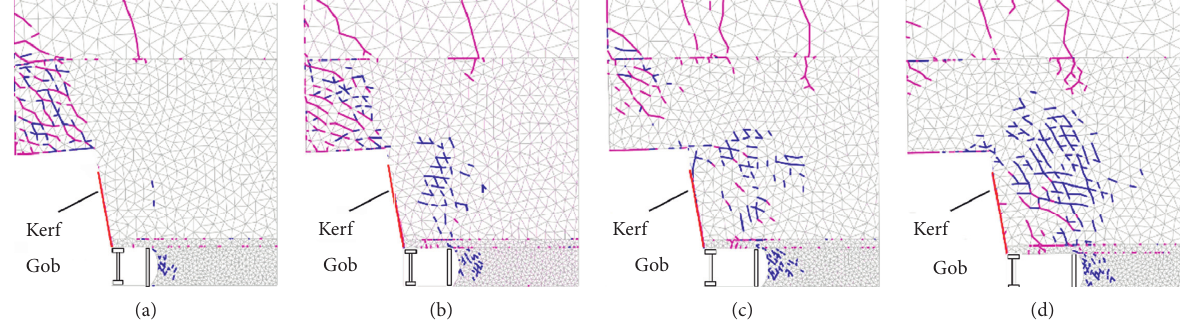
Figure 14: Fracture development in surrounding rock with varied roadway width (the pink line represents the open cracks and the blue line stands for the slip cracks: (a) 4m; (b) 5m; (c) 6 m; (d) 7m.